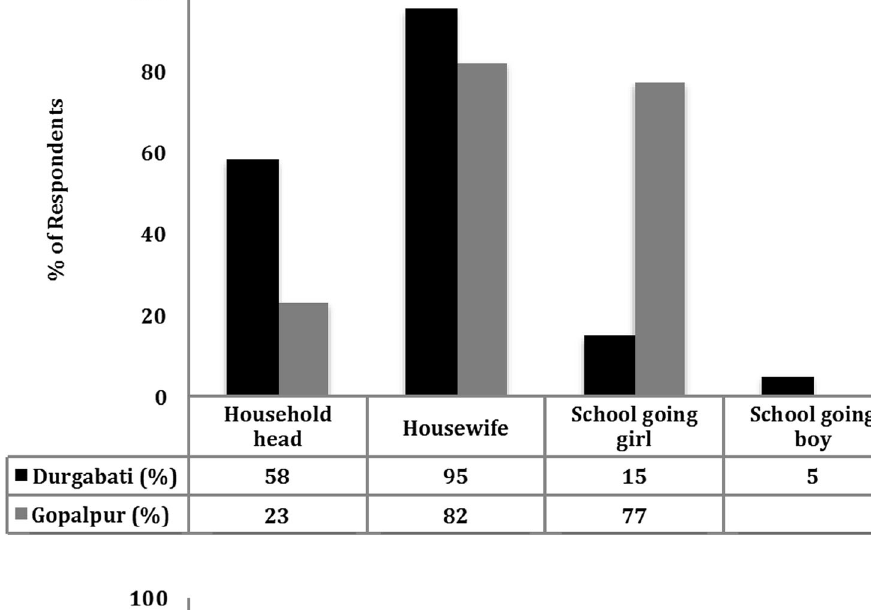
Fig. 12 Performance of water quality tests in the two study villages of southwestern coastal